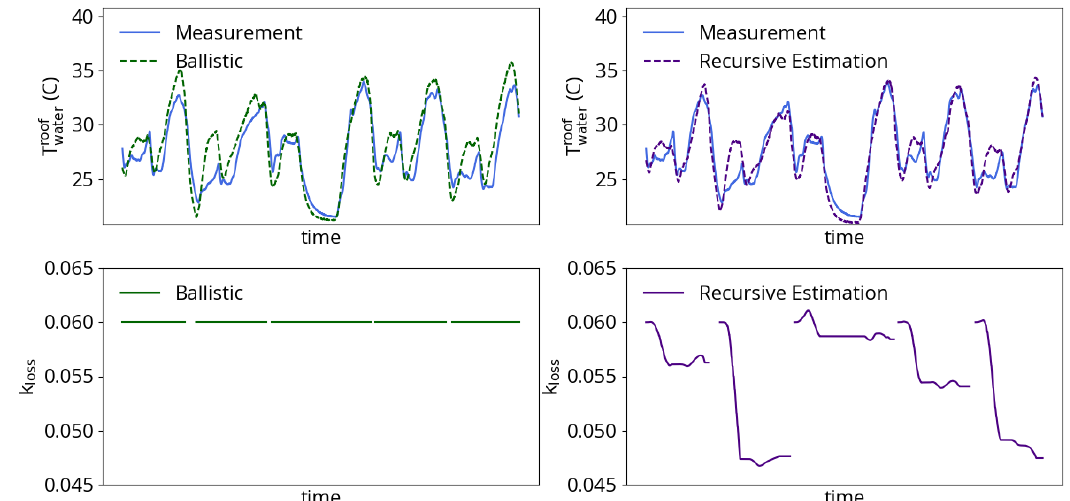
Figure 7. Example of arc loss coefficient k loss estimation during five consecutive two-basket heats. ( left ) A constant k loss produces model results that follow the cooling water dynamics but sometimes overpredict the outlet temperature. ( right ) Estimation of k loss produces more accurate model